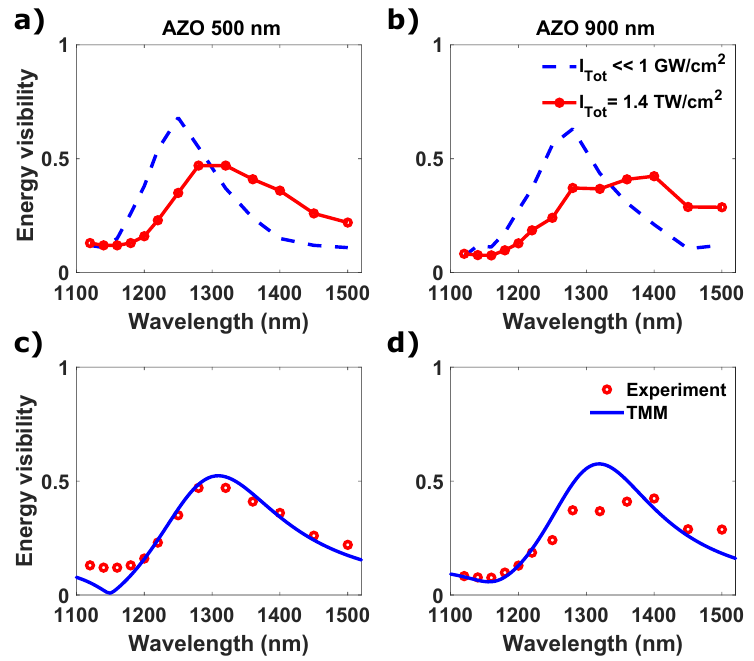
Figure 5. ( a , b ) Normalized visibility of the total energy for both samples, 500 nm ( a ) and 900 nm ( b ). The dashed blue curve represents the linear characterization, while the circles is the nonlinear CPA with high beam intensity. ( c , d ) Experimental (circles) and TMM simulation (solid line) of normalized visibility of the total energy for AZO 500 nm and 900 nm for the nonlinear